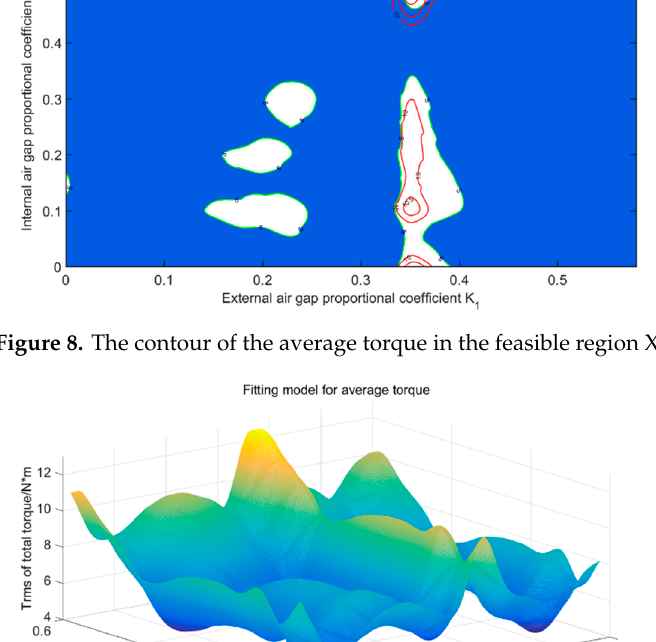
Figure 9. Three-dimensional fitting diagram of the torque fluctuation.